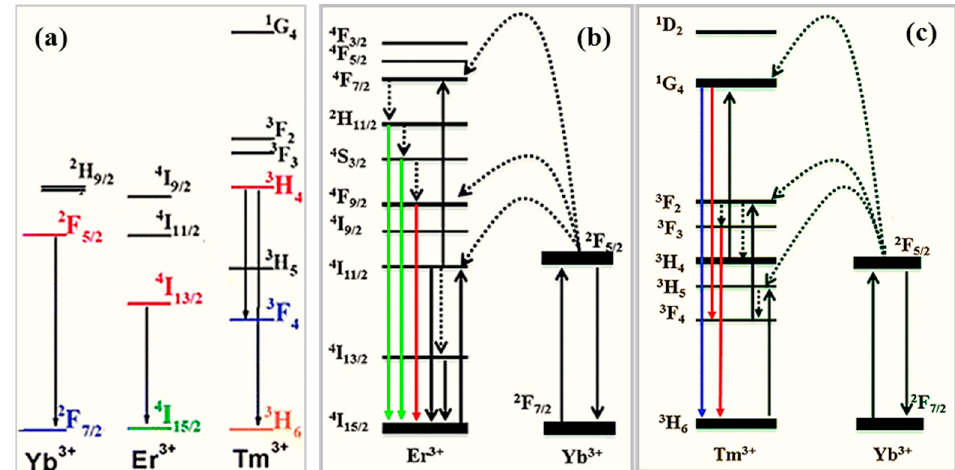
Figure 8. ( a ) Diagram of the energy levels of Yb, Er, and Tm and main radiative transitions. Scheme of the radiative emissions and energy transfer mechanisms of ( b ) Er-Yb pairs leading to green emission and ( c ) Tm-Yb pairs leading to blue emission.